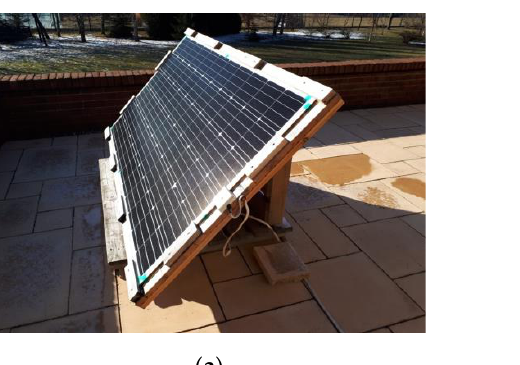
( d ) Figure 11. Read range r PwRMax of test samples: ( a ) determined for different values of output power of RWD P RWD and voltage on auxiliary power source V BAT ; ( b ) comparison of tests in anechoic chamber and in quasi-real conditions; ( c ) tests of passive and semi-passive mode in quasi-real conditions; ( d ) laboratory stand in anechoic chamber; inaccuracy of measurement method ± 1 cm. 3.2.3. Outside Tests